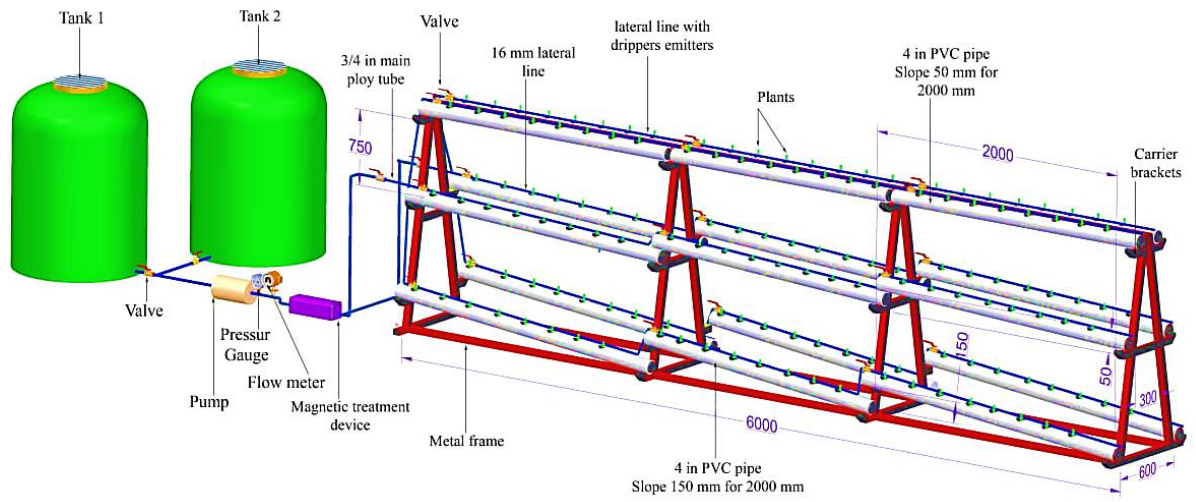
Figure A1. Engineering drawing and set-up showing the experimental hydroponic farming system with magnetic device.